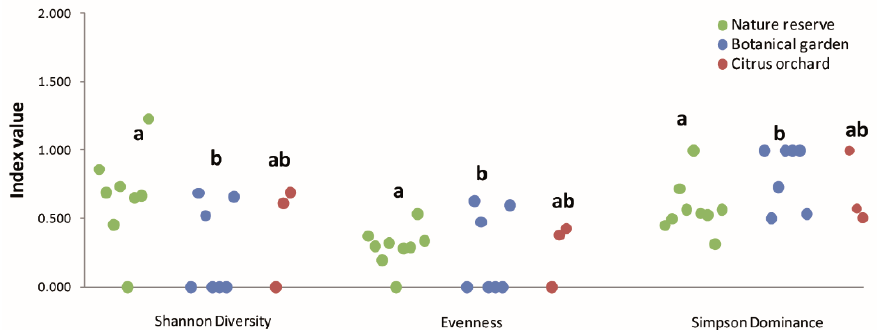
Figure 6. Values of the diversity indices, Shannon diversity, Pielou’s evenness and Simpson domi- nance, calculated basing on DNA metabarcoding Phytophthora -positive rhizosphere soil samples from the three surveyed areas. Data were analyzed with the Kruskal–Wallis test. Different letters indicate significant differences according to Dunn’s multiple comparison tests ( p ≤ 0.01).